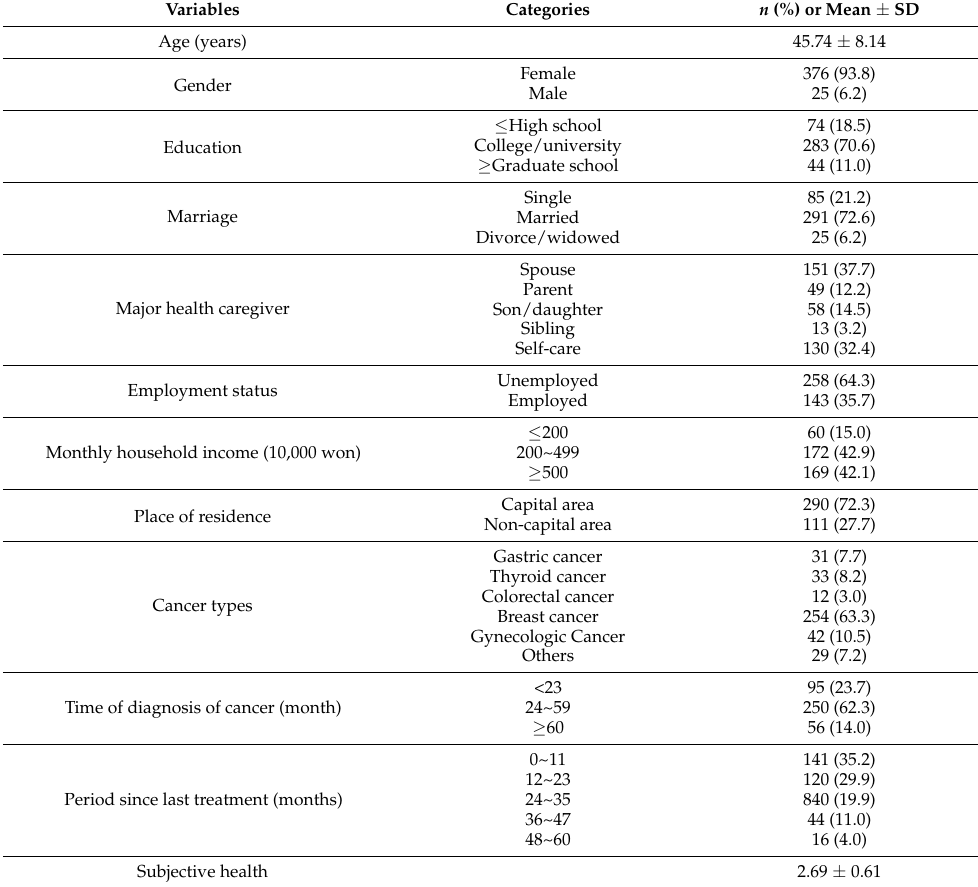
Table 1. Demographic and Clinical Characteristics ( N =